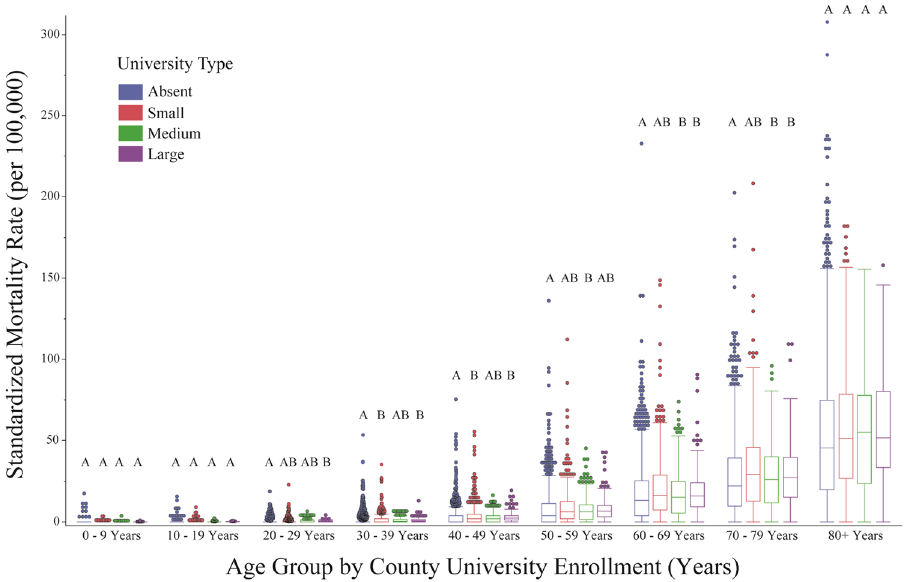
Figure 3. Box down breakdown of laboratory-confirmed mean SARS-CoV-2 age-adjusted mortality rates (per 100,000) by age-group (binned by 10-year intervals). Unique letters, arranged in descending order (highest mean value = A and so on), indicate statistically different groups, assessed by Student’s t-test ( p value ≤ 0.05). Individual circles represent outlier